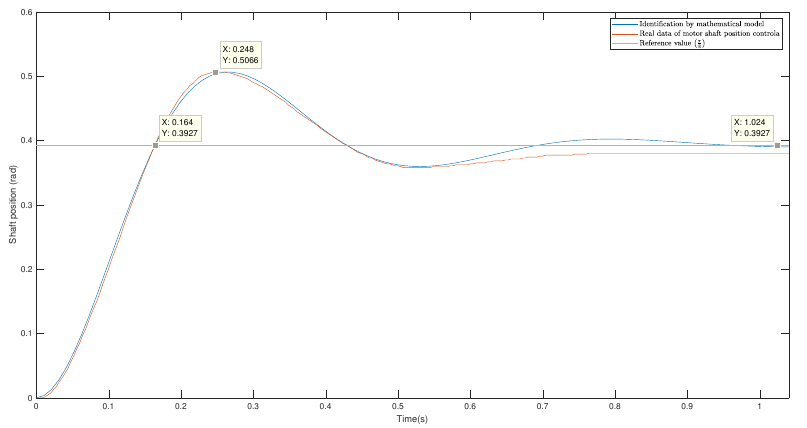
Figure 10. Comparison of the mathematical model obtained against the data of the proportional control of the motor shaft.